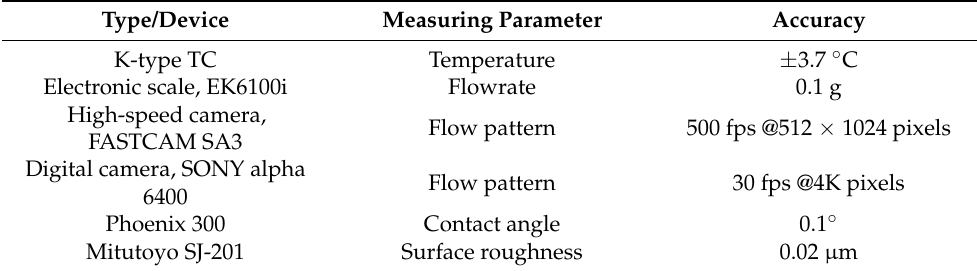
Table 1. Summary of sensors and equipment.